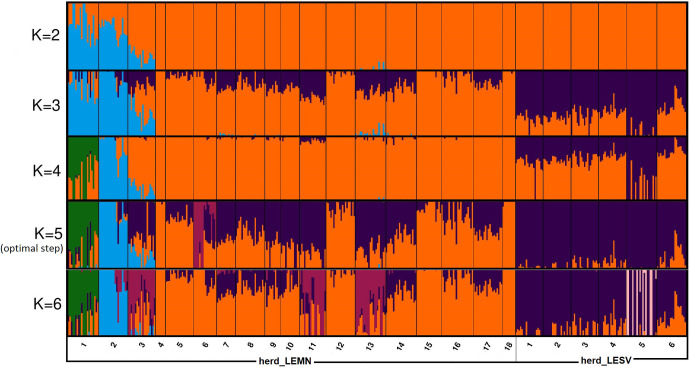
Genetic clusters as ancestry proportions of Lemnos and Lesvos sheep revealed by admixture analysis in fastStructure [11].The x-axis represents individuals sorted according to herd_ID within islands. Each color represents a population and each individual is represented by a vertical line partitioned into colored segments whose lengths represent the admixture proportions from K ancestral populations. Plots were constructed in CLUMPAK (http://clumpak.tau.ac.il/, [12]).